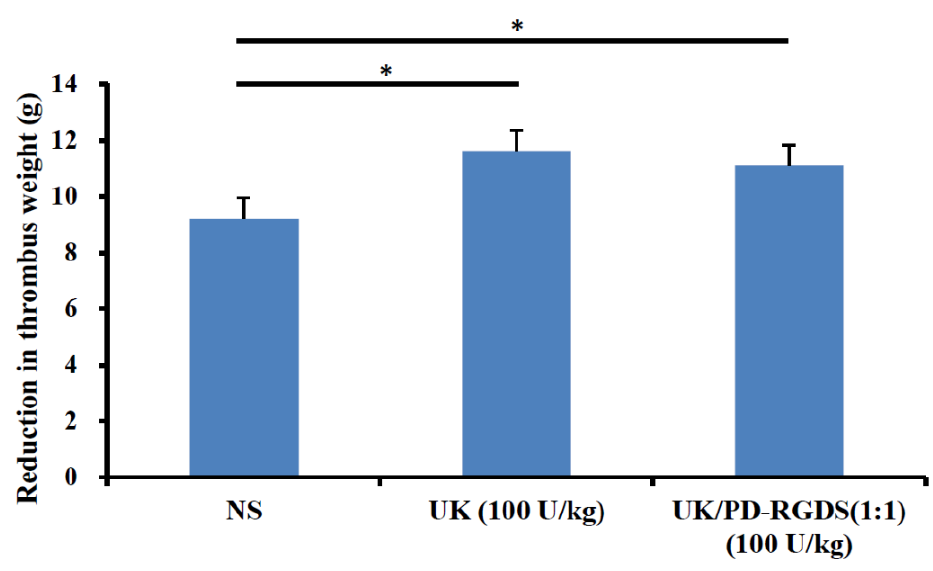
Figure 5. The thrombus clot lysis activity of UK/PD-RGDS complex (n = 9). * p < 0.05.